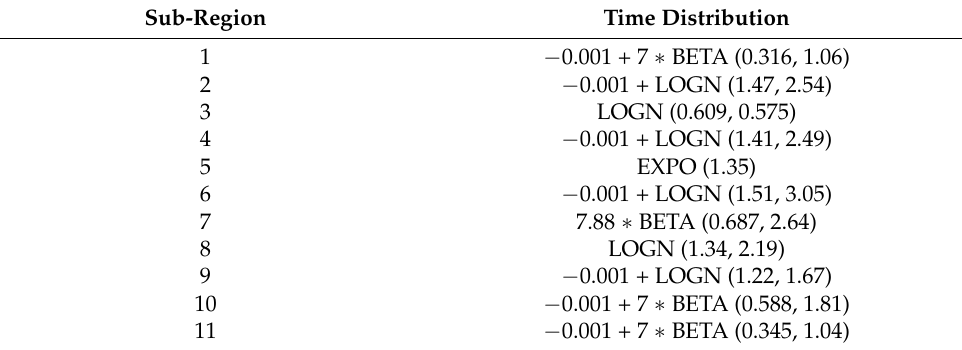
Table 5. Time distribution of request generation for each region of input analyzer.